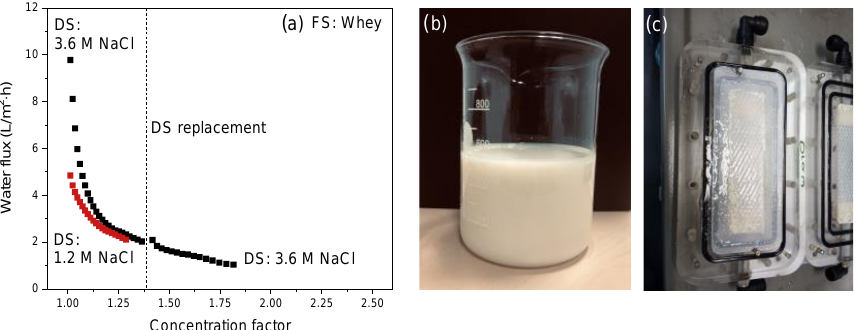
Figure 10. ( a ) Water flux as a function of the concentration factor using whey as FS. The intermission in the curve is due to the refreshing of the DS to reset it to 3.6 M NaCl; ( b ) Initial cheese whey feed; ( c ) Opened membrane cell after the whey concentration process.